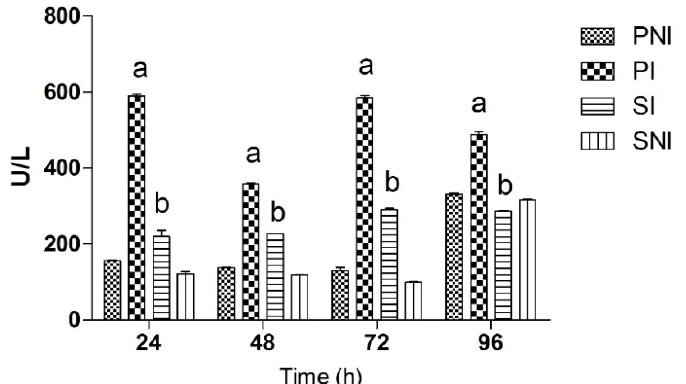
Figure 2. Serum lactate dehydrogenase (LDH) levels for all groups of male Wistar rats at 24, 48, 72 and 96 h after exposure to